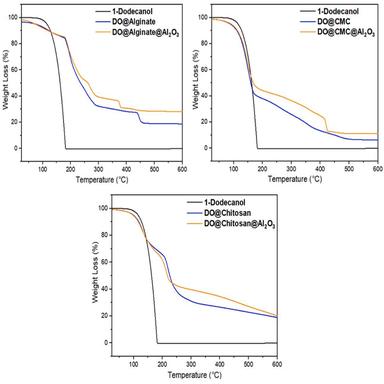
Mass loss of 1-Dodecanol, EPCMs with and without nano-Al2O3.